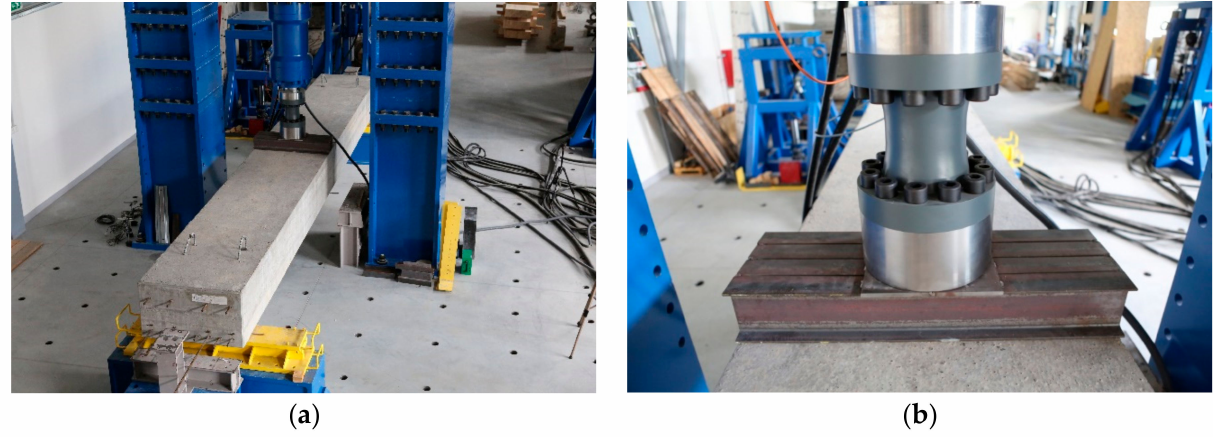
Figure 8. Three-point loading test in Centre of Building Experiments ( a ), and spreading of concentrated force with steel element ( b